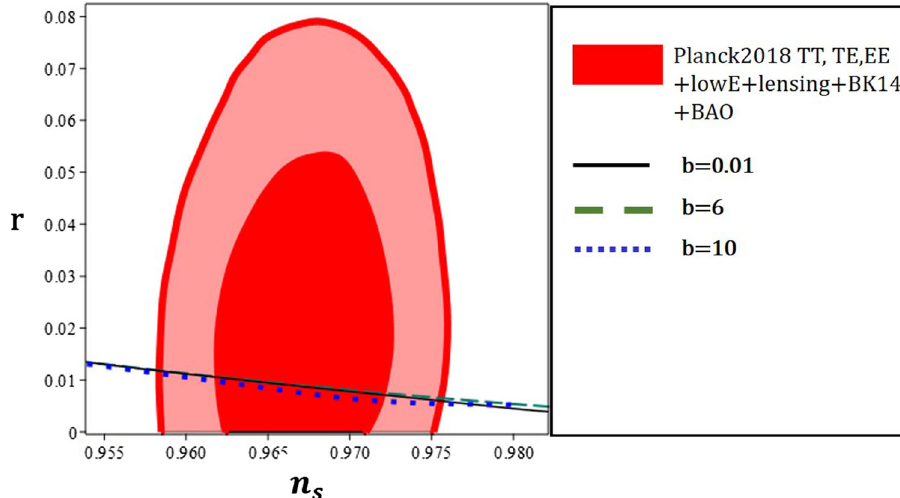
Fig. 6 Tensor-to-scalar ratio versus the scalar spectral index for the intermediate MDBI model. To plot this figure, we have adopted 0 < β < 1 and N =